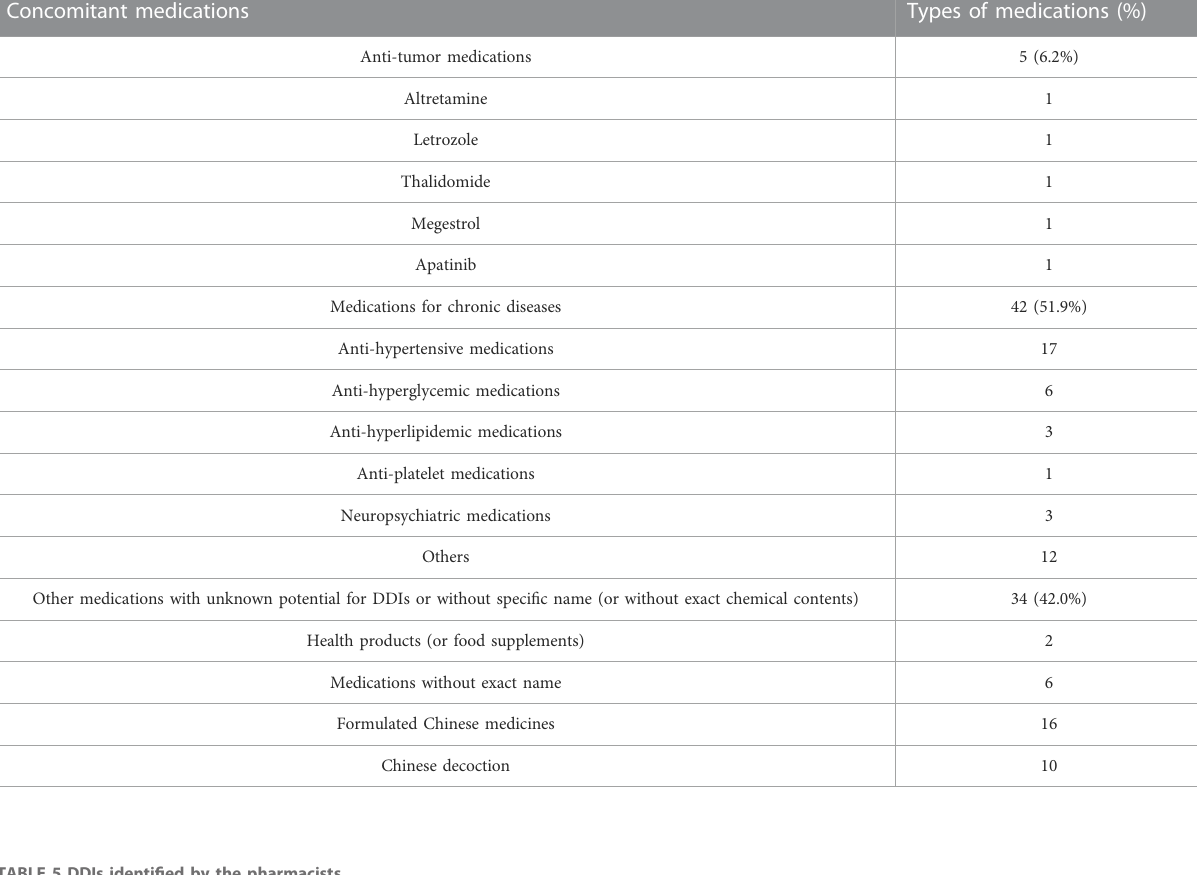
TABLE 4 Concomitant medications in patients receiving olaparib.